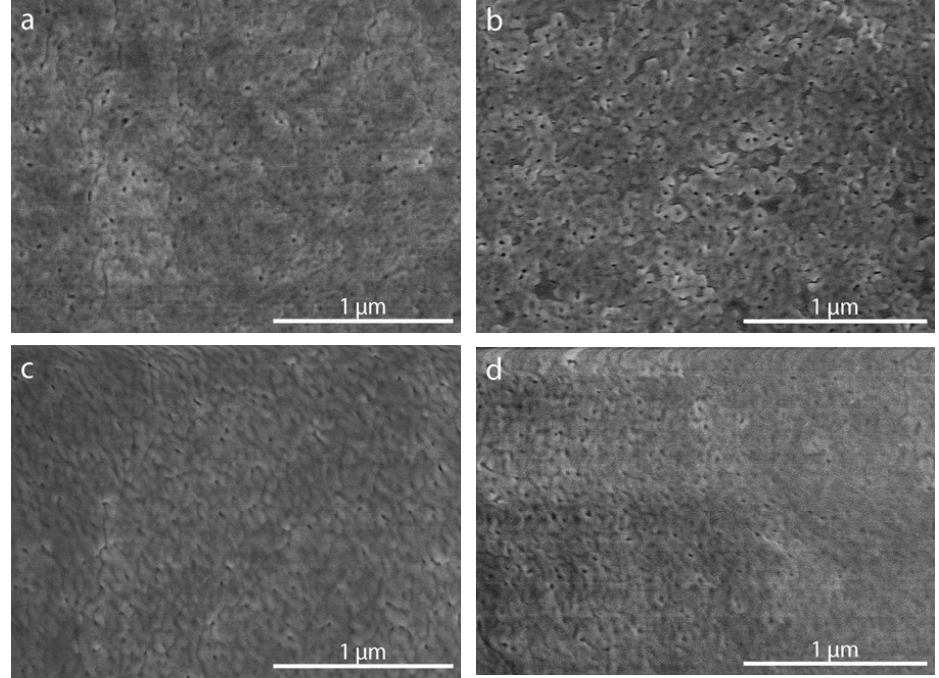
Figure 7. Plane view SEM images of the BLFSO films deposited on Pt/TiO 2 /SiO 2 /Si ( a ), silicon ( b ), 7 sapphire ( c ) and fused silica ( d